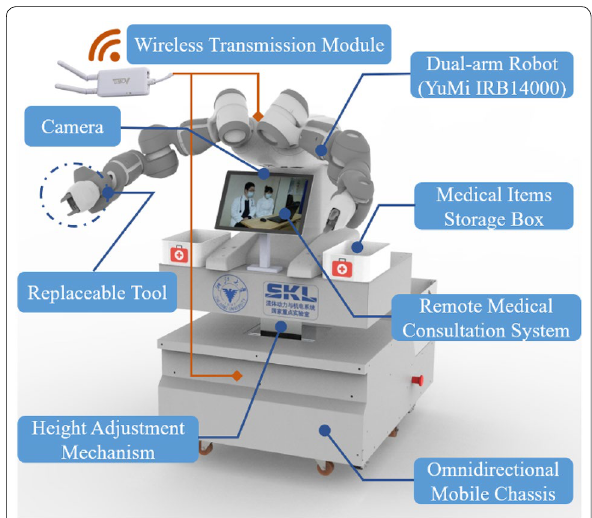
Figure 2 Structure of the self-designed teleoperated